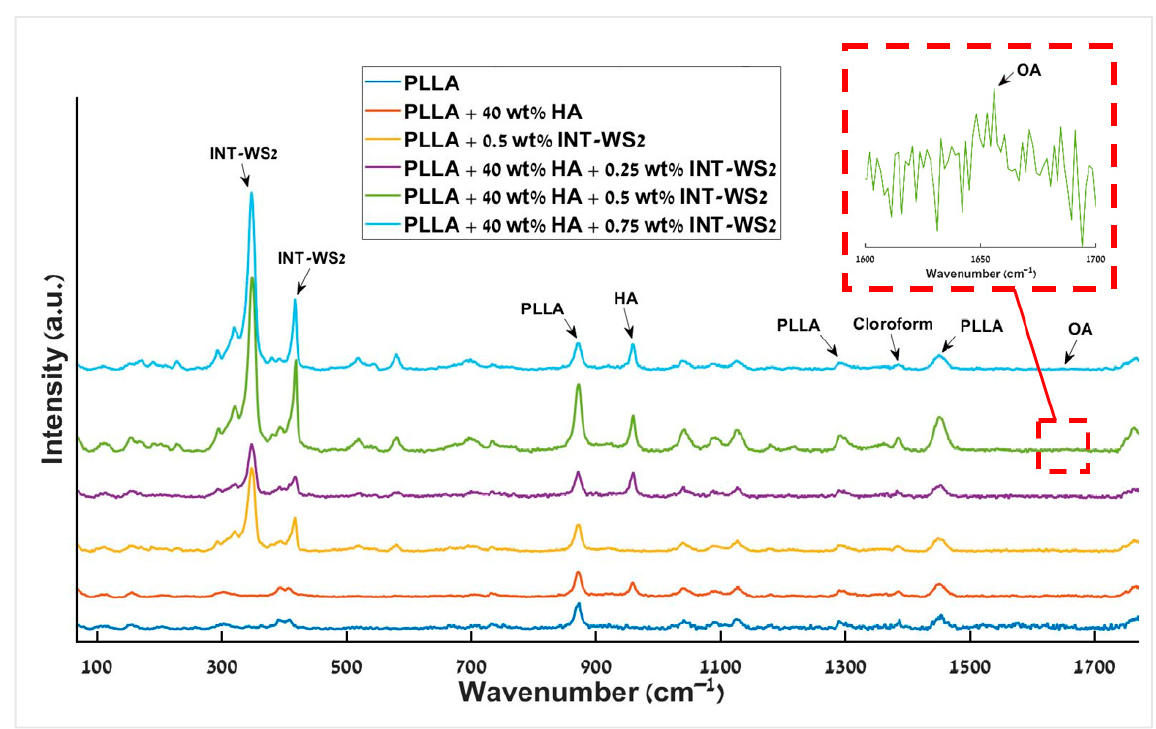
Figure 9. Raman spectra of the different PLLA films and PLLA/HA/INT-WS 2 nanocomposites films. The Raman peak of the oleic acid is shown in the inset.